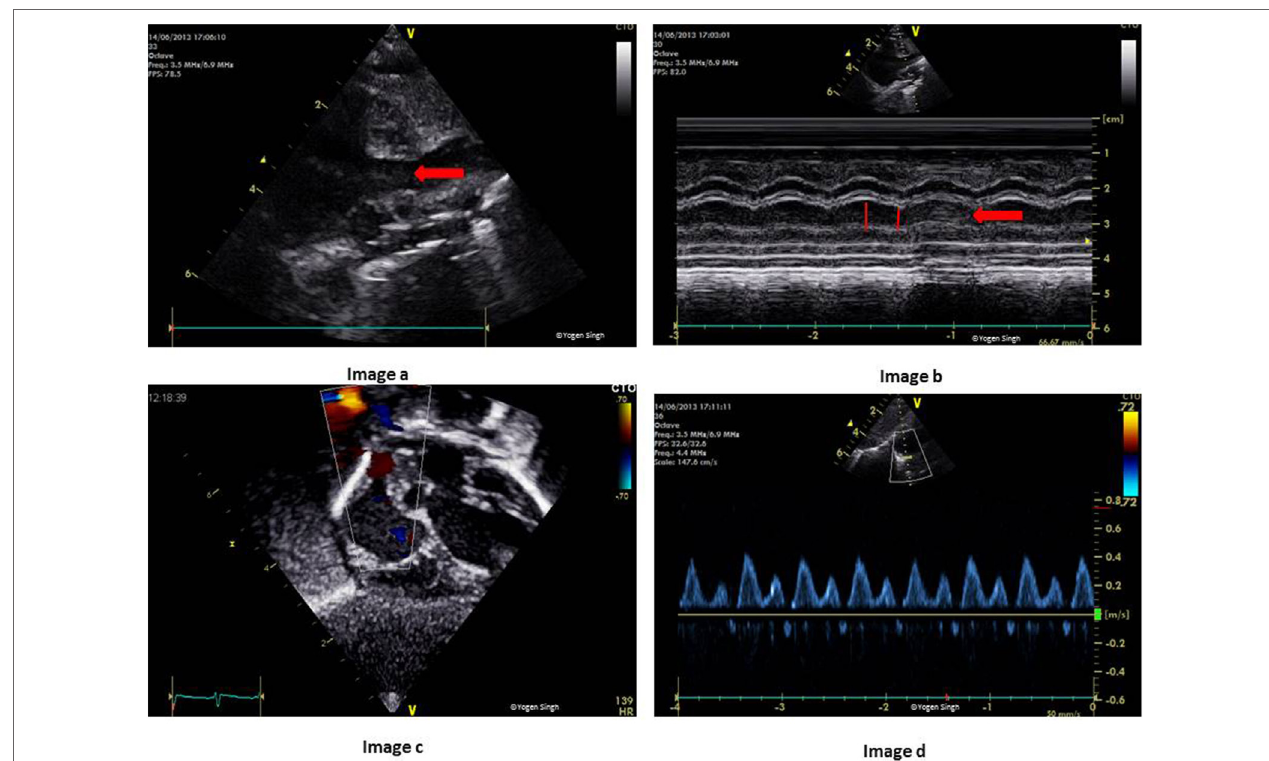
FiGURe 12 | Measurement of superior vena cava (SVC) flow on echocardiography. Image a shows SVC in modified parasternal short axis view on 2D and image b with measurement of SVC diameter in M-mode. Image c shows acquisition of pulse-wave Doppler in the sub-costal view and SVC flow in milliliters per minute has been calculated in image d after measuring velocity time